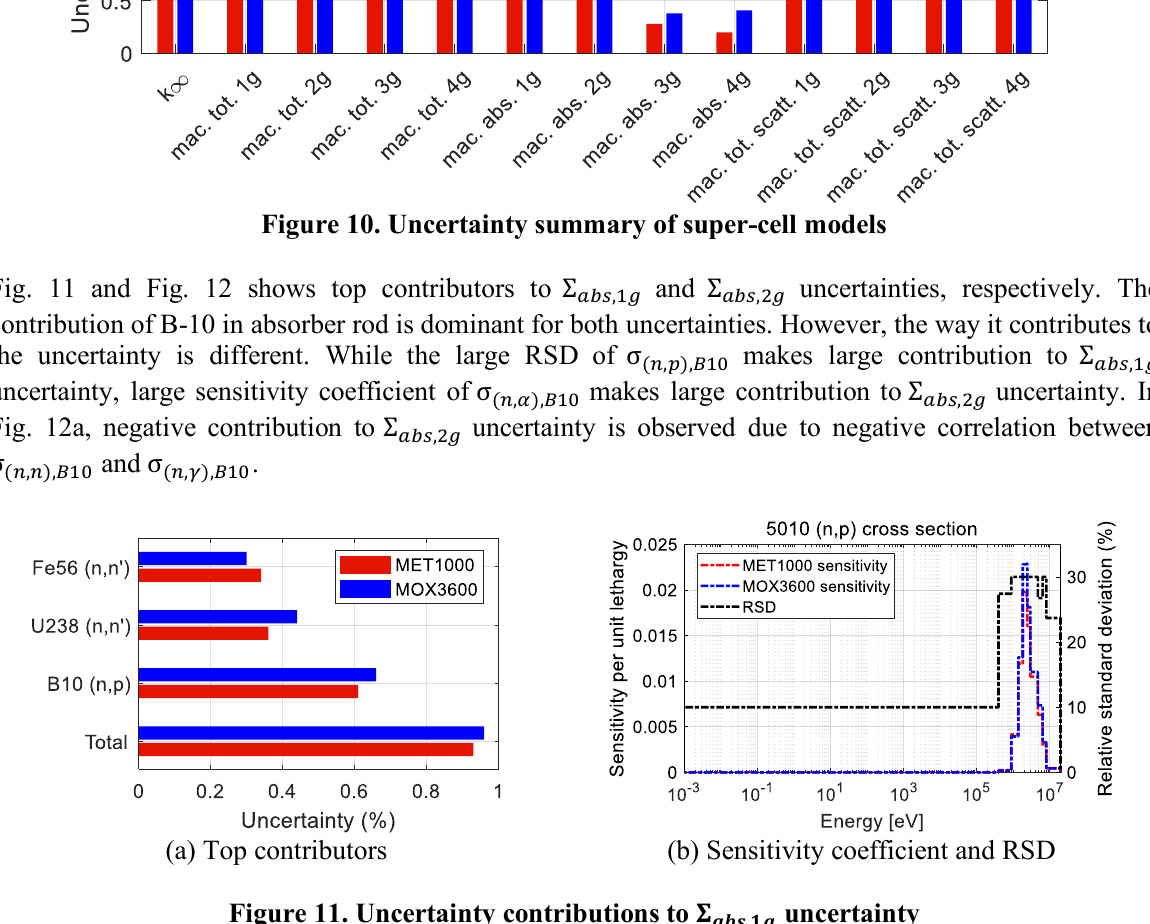
Figure 11. Uncertainty contributions to 𝚺